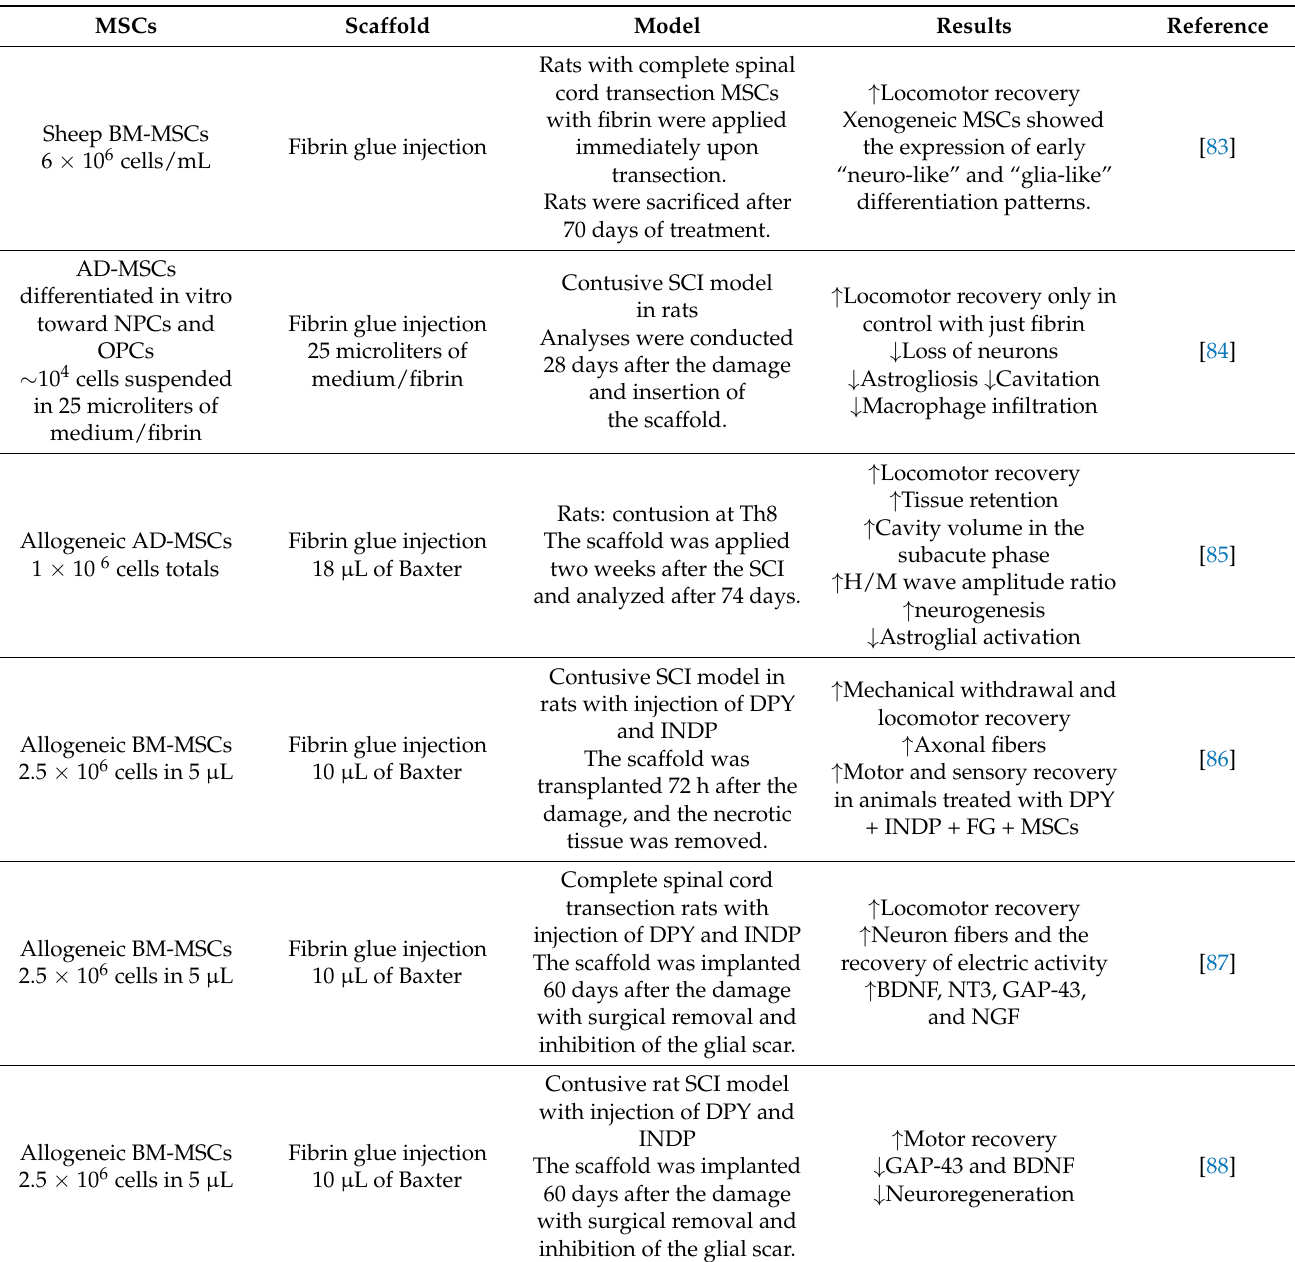
Table 2. Overview of the studies evaluating biochemical and cellular changes using MSC-enriched fibrin scaffolds in in vivo